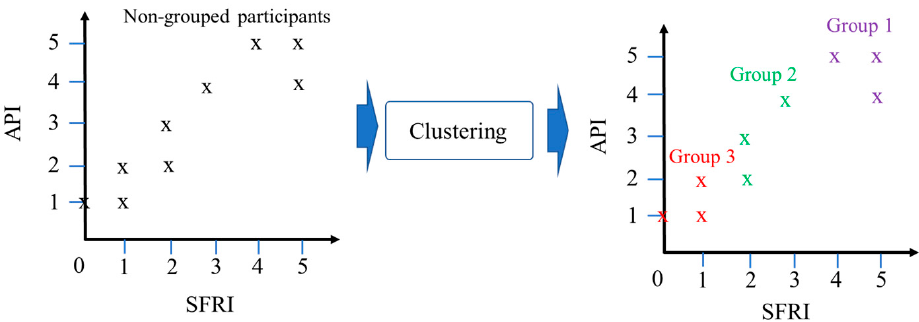
Figure 2. Representation of the clustering process by taking into account nine participants and two attributes.